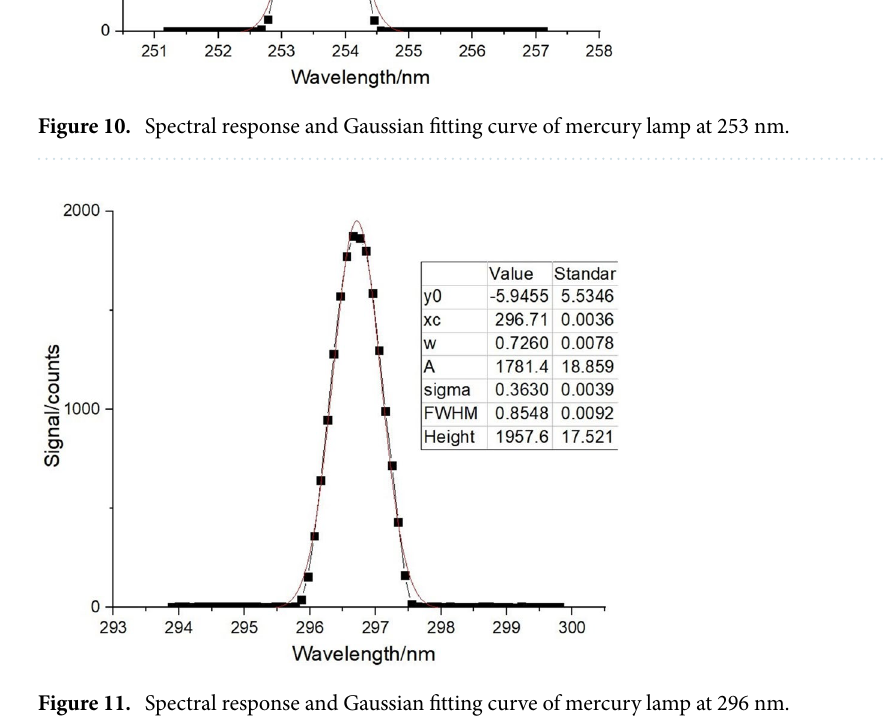
Figure 11. Spectral response and Gaussian fitting curve of mercury lamp at 296 nm.